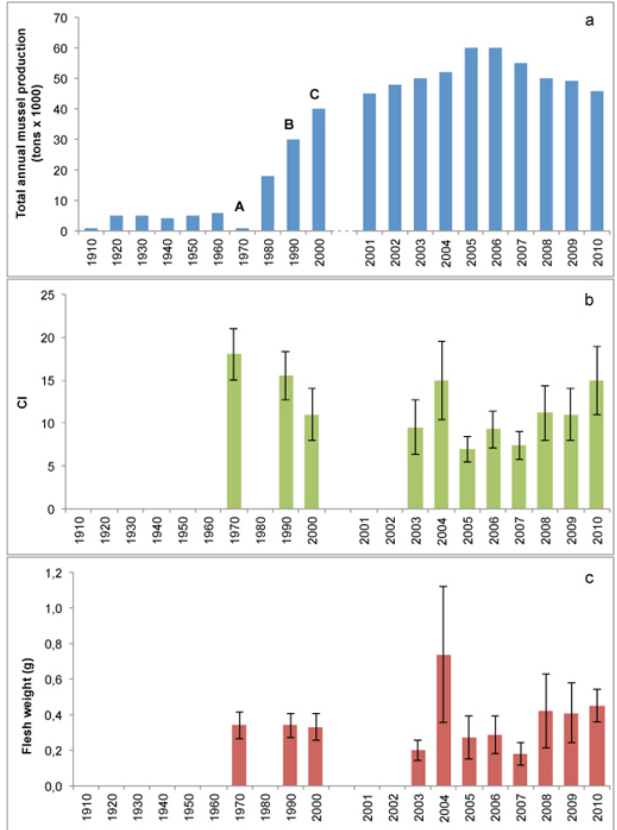
Fig. 2 . (a) Changes in Taranto mussel production, (b) quality (expressed as condition index – CI), and (c) flesh weight (expressed as dry weight). Letters in the first panel identify the following events: (A) cholera epidemic (1973); (B) crisis of the heavy industry that made many farmers return to their old occupations; introduction of long-lines; (C) policy changes and illegal occupation of new areas (G. Portacci, unpublished data